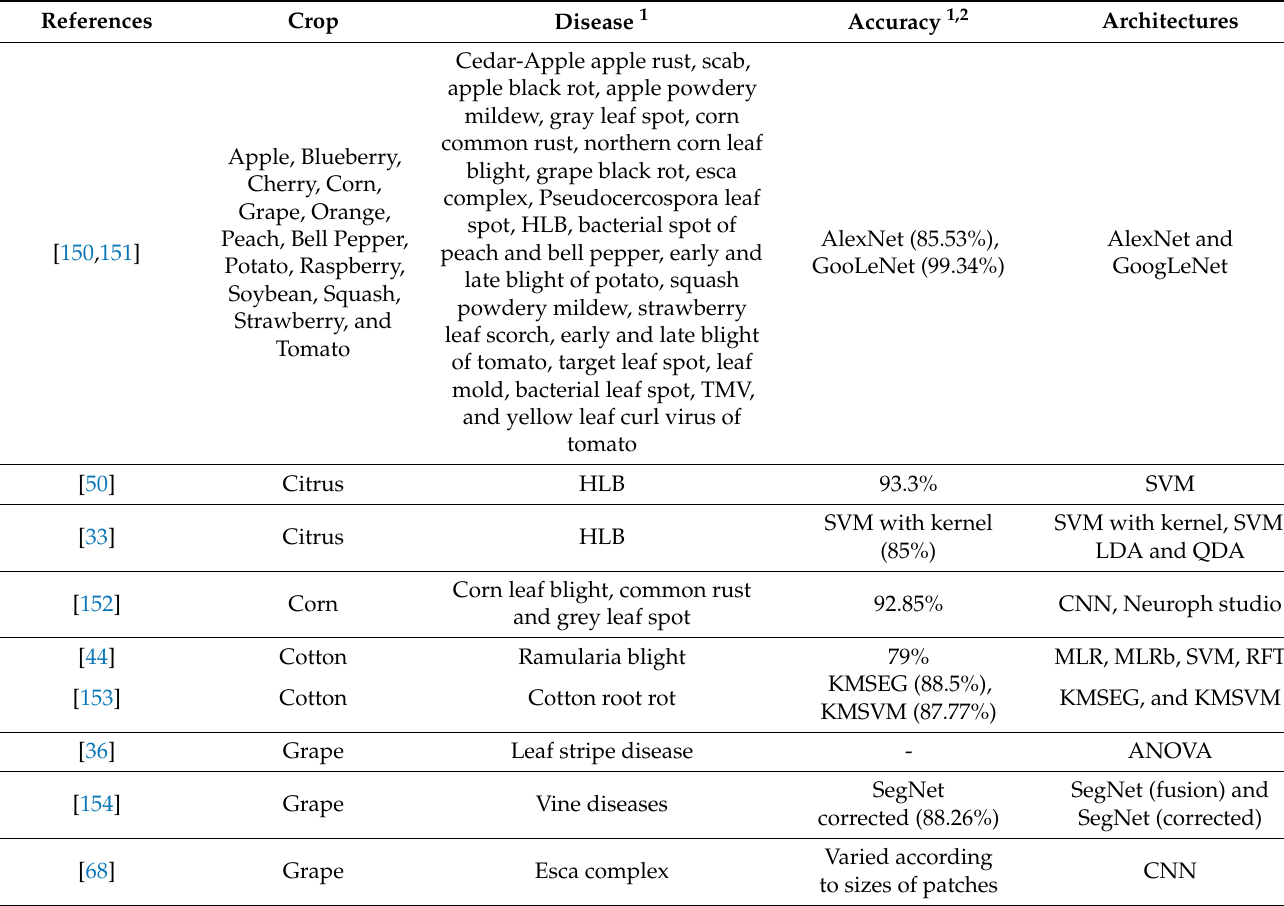
Table 1. Different deep learning CNN models used for the automatic identification of diseases in